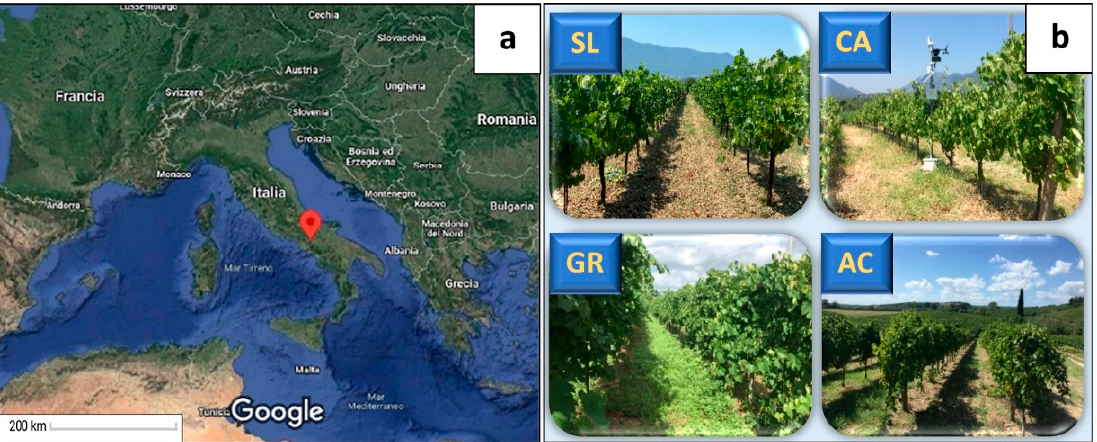
Figure 1. Location of the study area in Southern Italy ( a ) and images of the four study sites: SL, Santa Lucia; CA, Calvese; GR, Grottole; and AC, Acquefredde ( b ). Source: Google Maps ©2021.